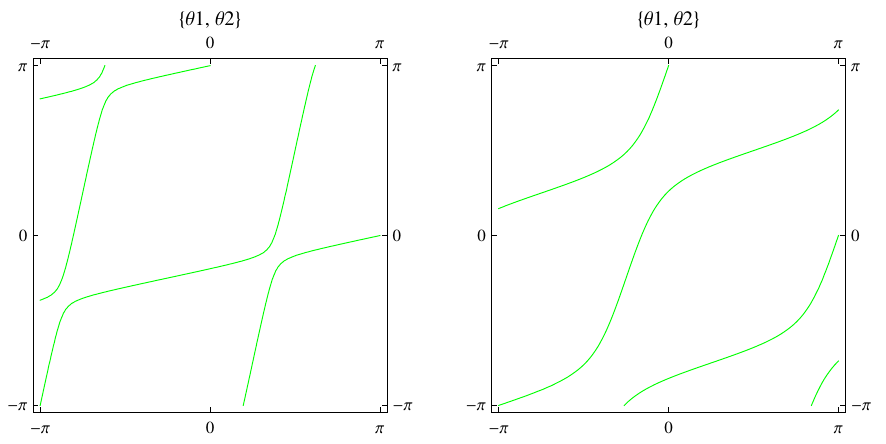
Figure 9 . The figures show the family of curves in the plane θ 1 × θ 2 defined by (4.27) for θ 0 = 2 π and the cases (cid:15) 0 = +1 (left figure) and (cid:15) 0 = − 1 (right